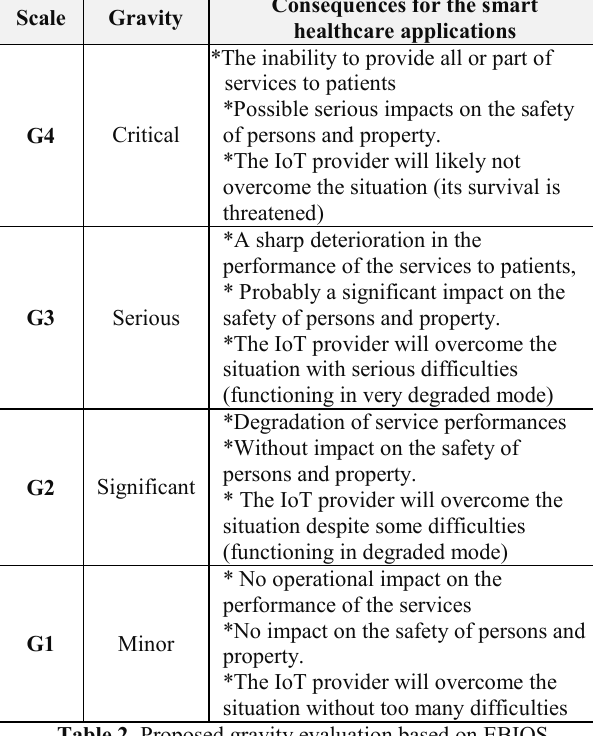
Table 2. Proposed gravity evaluation based on EBIOS